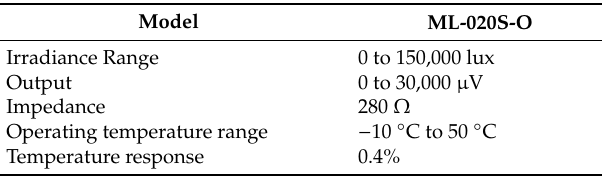
Table 2. Luxmeter technical specifications.